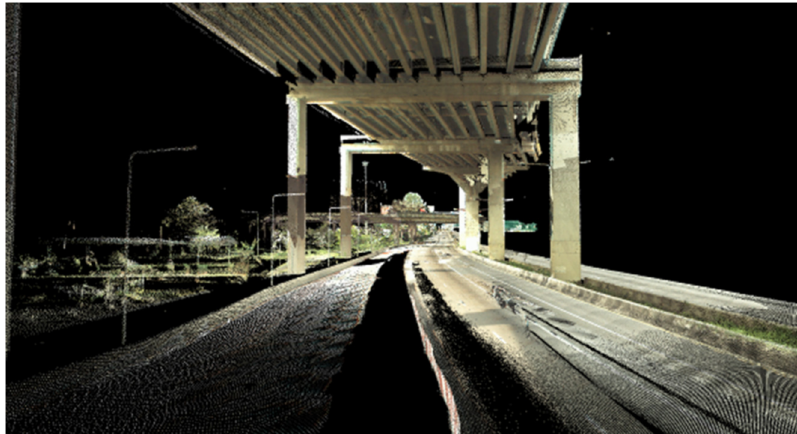
Figure 5. Pavement and expressway